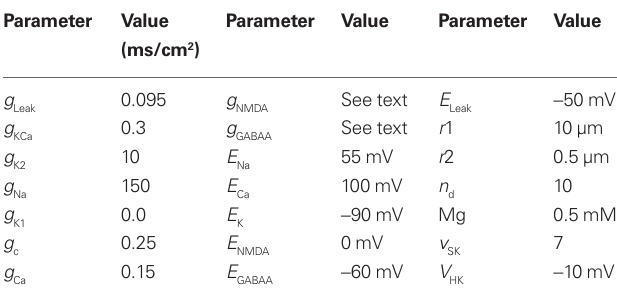
Table 1 | Parameters used in the compartmental model.